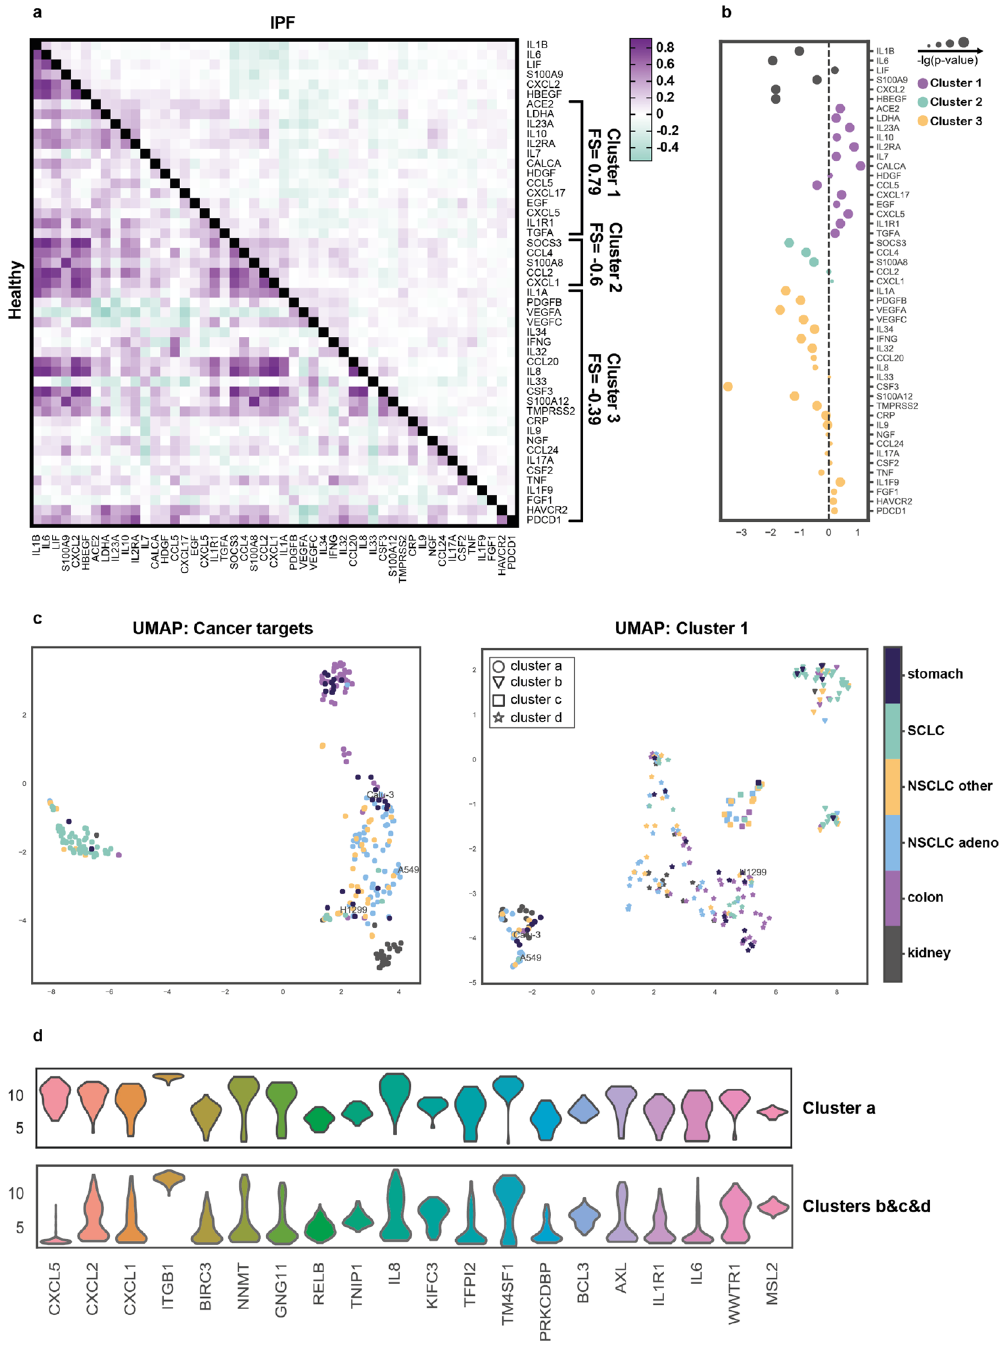
Figure 2. Fibrosis scoring of SARS-CoV-2 associated cytokines. ( a ) Correlation matrixes of 49 SARS- CoV-2 associated cytokine coding genes expression in the healthy lung (lower-left half) and IPF (upper-right half) samples. Pearson correlation coefficient was calculated for each gene pair and genes were clustered by Ward’s method and then bootstrapped. Fibrosis scores (FS) are indicated for each cluster. ( b ) The difference in expression of genes in healthy lung samples and IPF. ( c ) UMAP analysis of 65 non-small cell lung cancer (NSCLC) adenocarcinoma, 44 NSCLC of other origins, 59 small cell lung cancer (SCLC), 31 kidney cancer, 50 colon cancer, and 28 stomach cancer cell lines from Sanger dataset. UMAP was performed using cancer-related drug targets (Cancer targets) gene set and 14 genes from Cluster 1. Cells were then clustered (clusters a–d) using HDBSCAN algorithms due to their proximity after UMAP analysis by Cluster 1 genes. ( d ) Differentially expressed genes for Cluster a and Clusters b & c & d